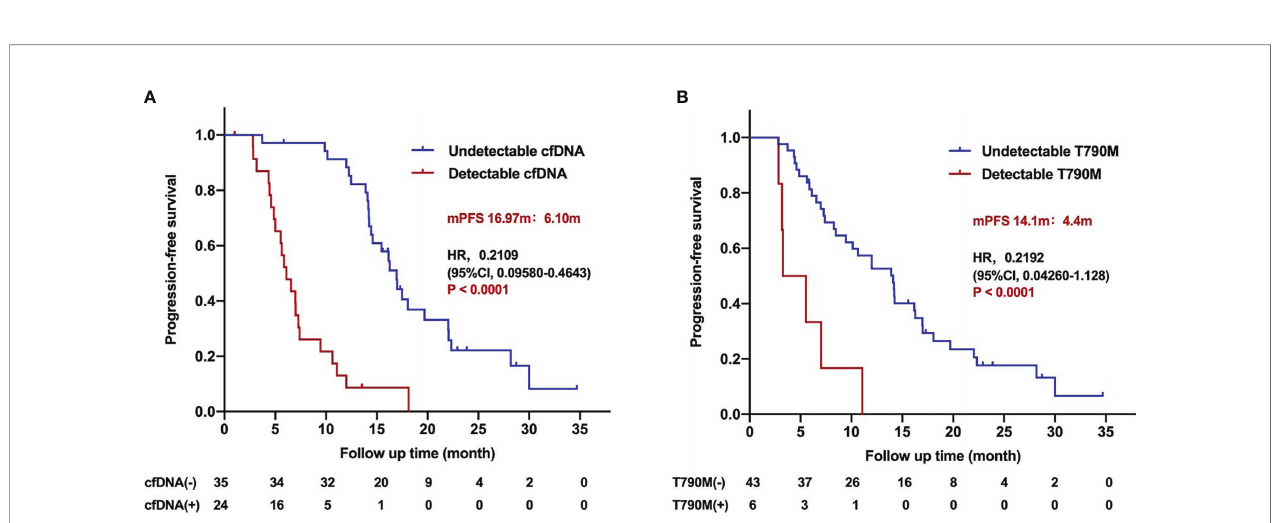
FIGURE 4 | Progression-free survival for patients treated with the third-generation EGFR TKIs according to dynamic cfDNA and T790M level during treatment. (A) Kaplan – Meier analysis strati fi ed by cfDNA level. (B) Kaplan – Meier analysis strati fi ed by T790M